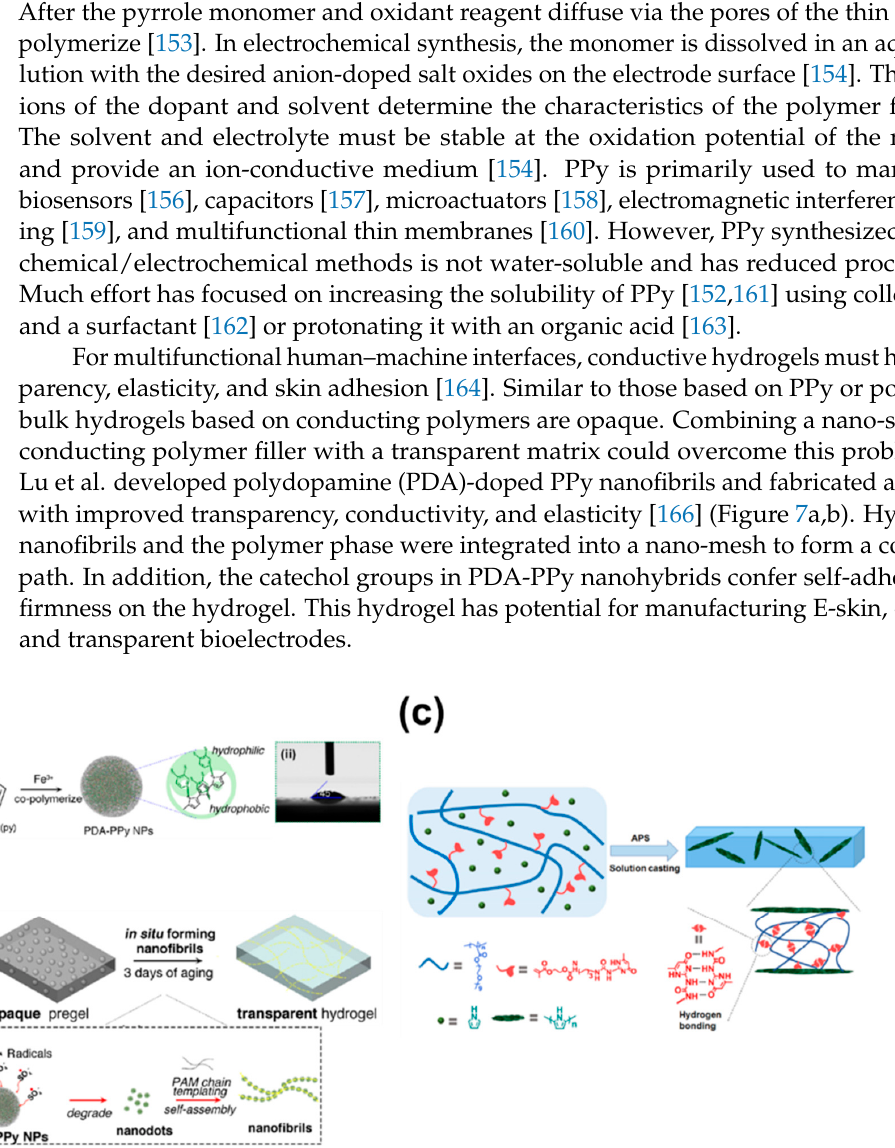
Figure 7. Schematic illustrations of fabrication processes. ( a ) Transparent, conductive, stretchable hydrogel of PDA-PPy nanofibrils [166]. Copyright © 2018, American Chemical Society. ( b ) Formation of a transparent hydrogel and PDA-PPy nanofibrils [166]. Copyright © 2018, American Chemical Society. ( c ) Fabrication of PPy-doped composite from hydrogen-bonded supramolecular elastomer [167]. Copyright © 2019, American Chemical Society.